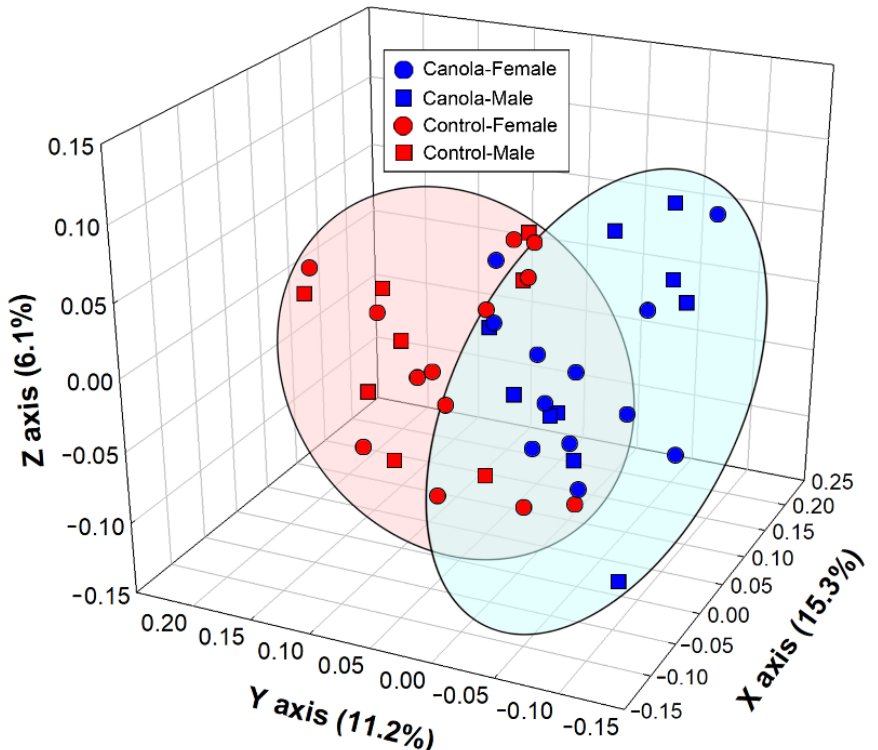
Figure 3. Principle coordinate analysis (unweighted UniFrac) of bacterial communities in the cecal digesta of female and male 35-day-old broilers fed a diet supplemented with canola meal (20%) or a control diet. Ellipsoids highlight the differences in community structure between communities in the digesta of birds fed the canola meal and control diets. The cecal communities differed between the two diets as determined by Jaccard ( p = 0.001), Bray Curtis ( p = 0.001), and unweighted ( p = 0.001) and weighted ( p = 0.016) UniFrac analyses.